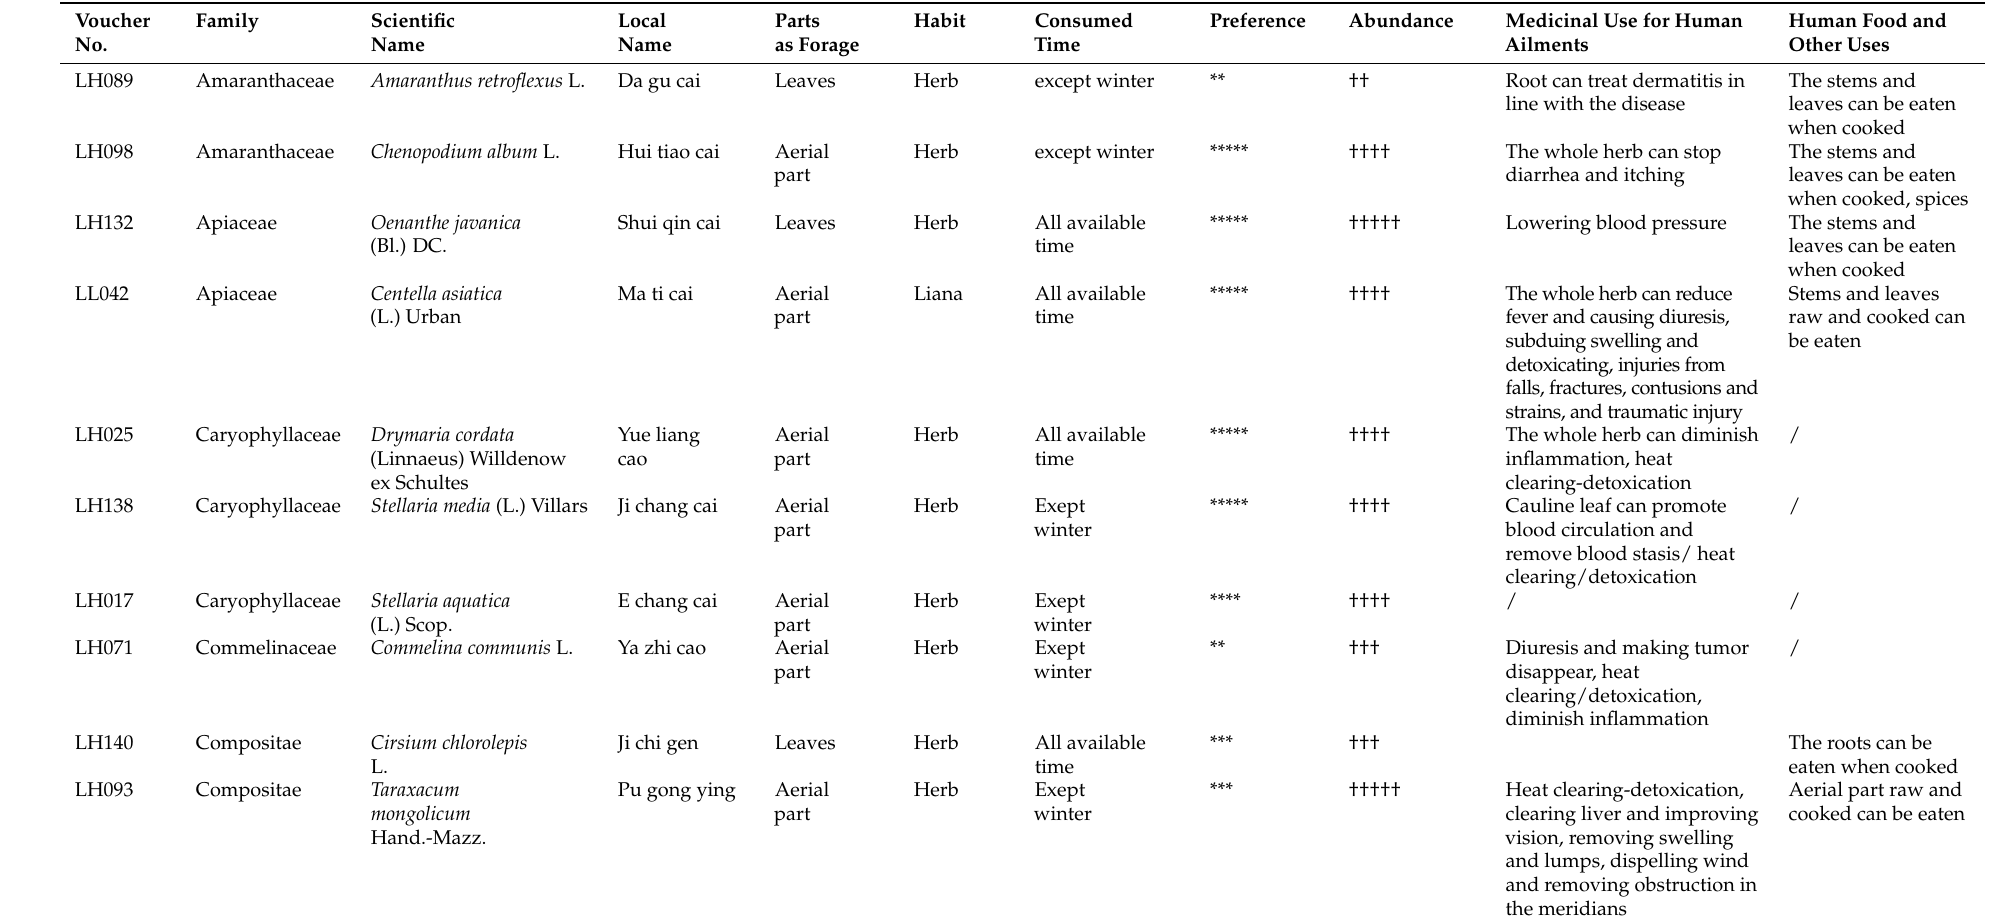
Table 2. Ethnobiological inventory of forage plants to feed Gaoligongshan pigs and other traditional uses. Voucher